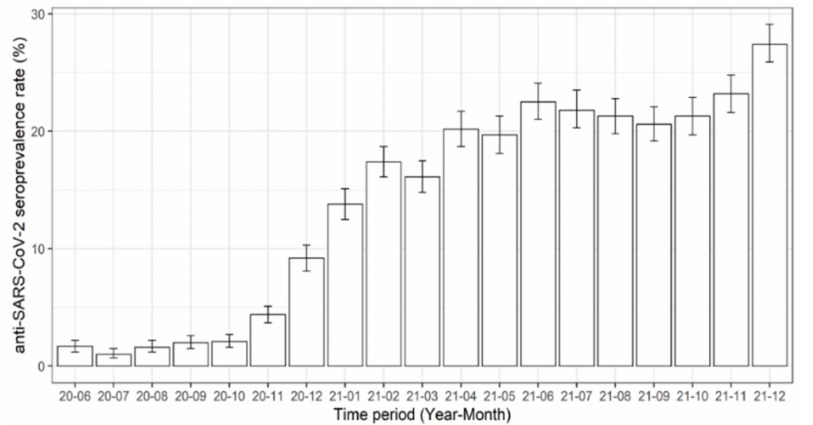
Figure 1. Seroprevalence rates of blood donations screened positive for SARS-CoV-2 anti-N total antibodies in Salzburg, Austria. Time is indicated as